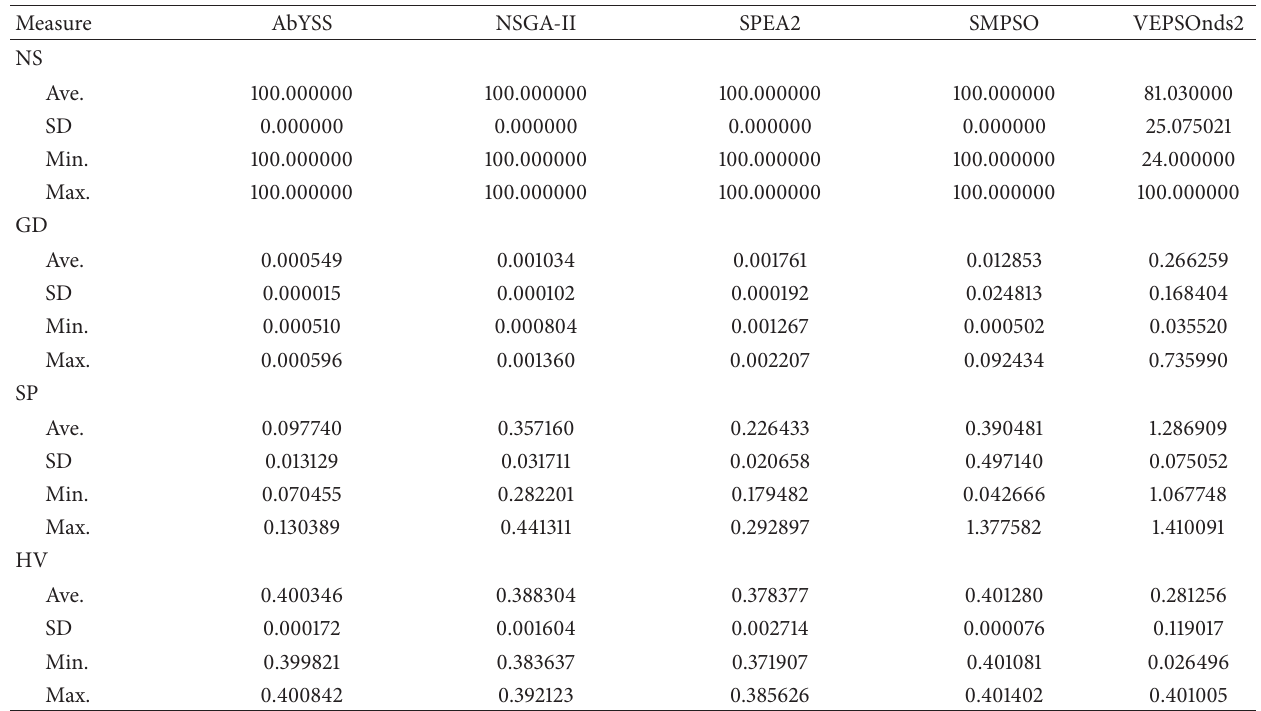
Table 10: Performance comparison based on ZDT6 test